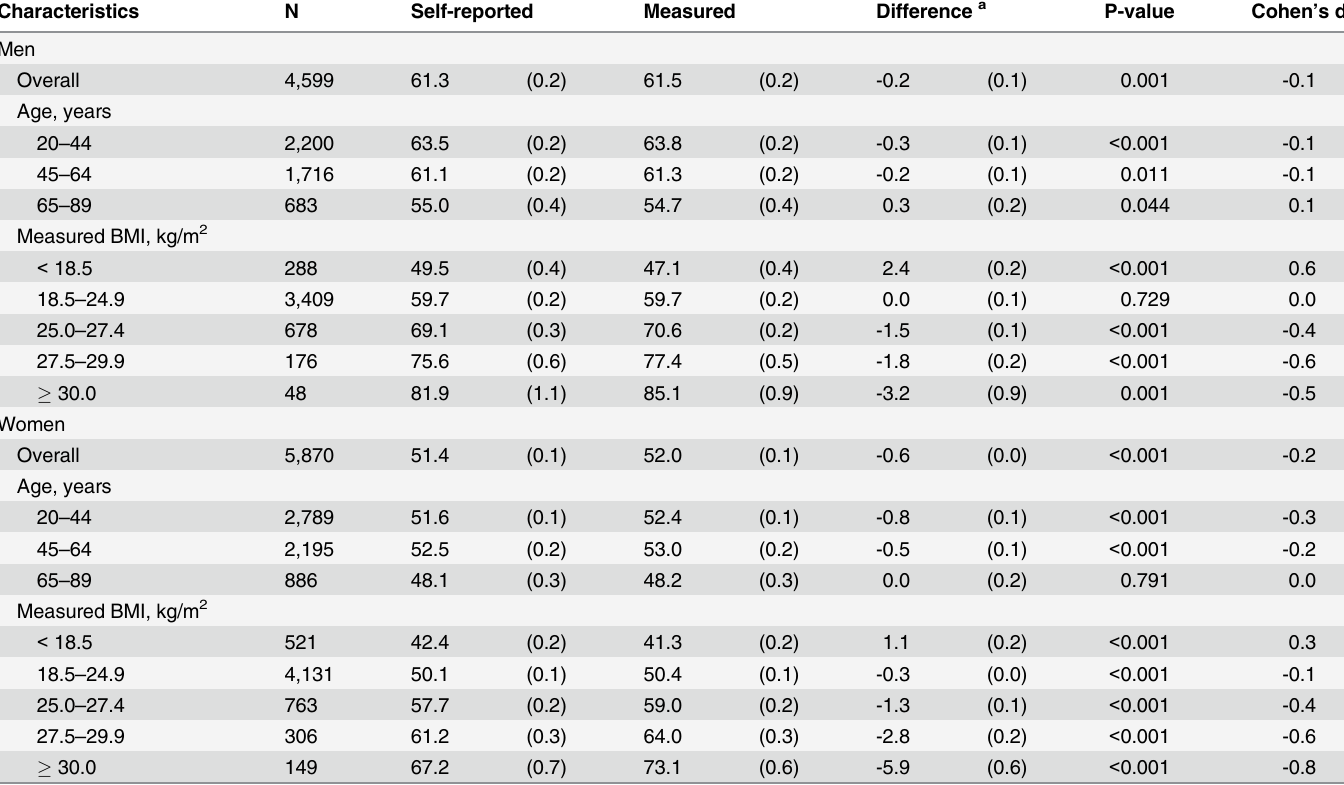
Table 2. Differences between self-reported and measured means of weight by characteristics of participants based on the National Nutrition Sur- vey, 1986.